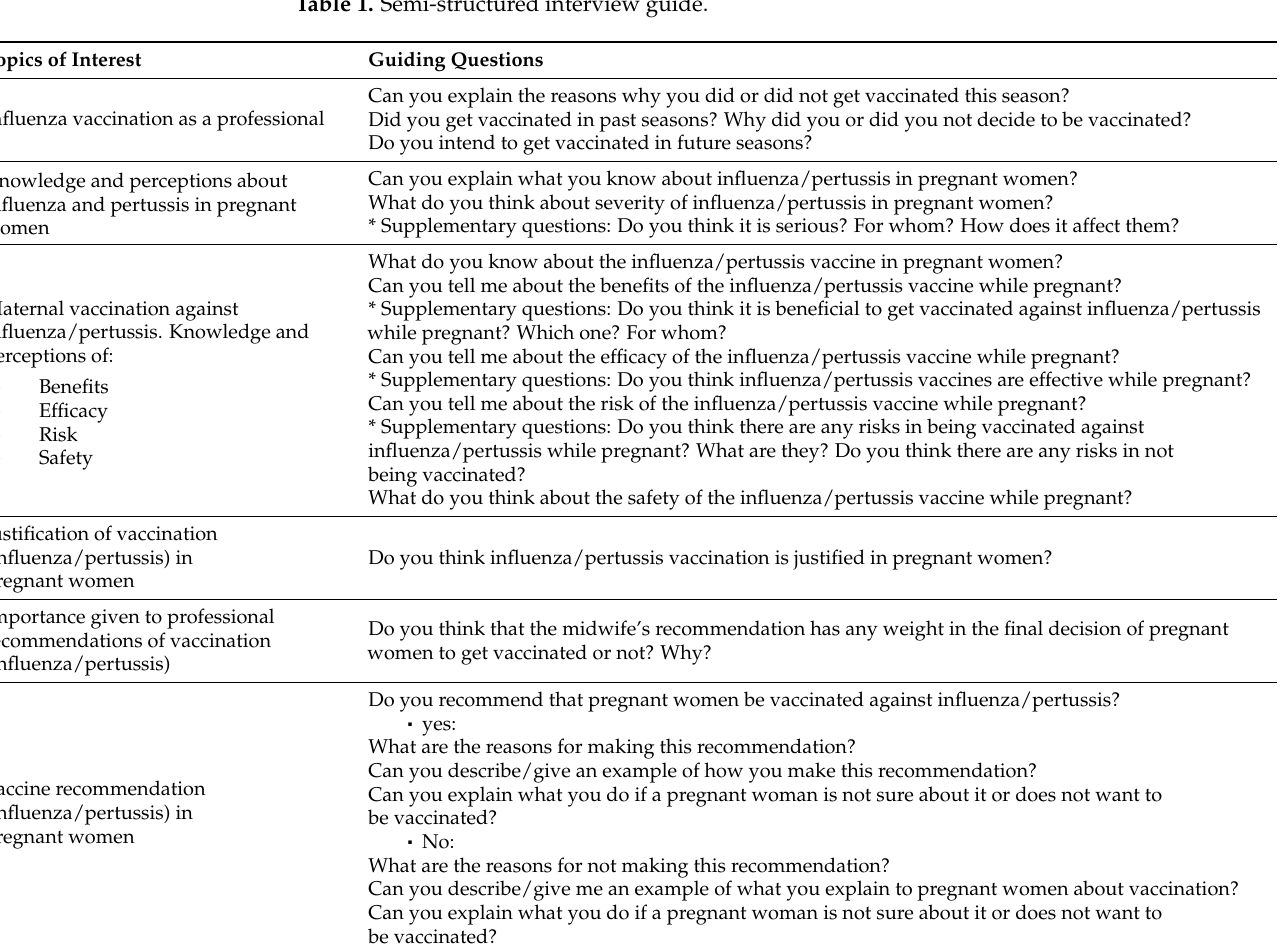
Table 1. Semi-structured interview